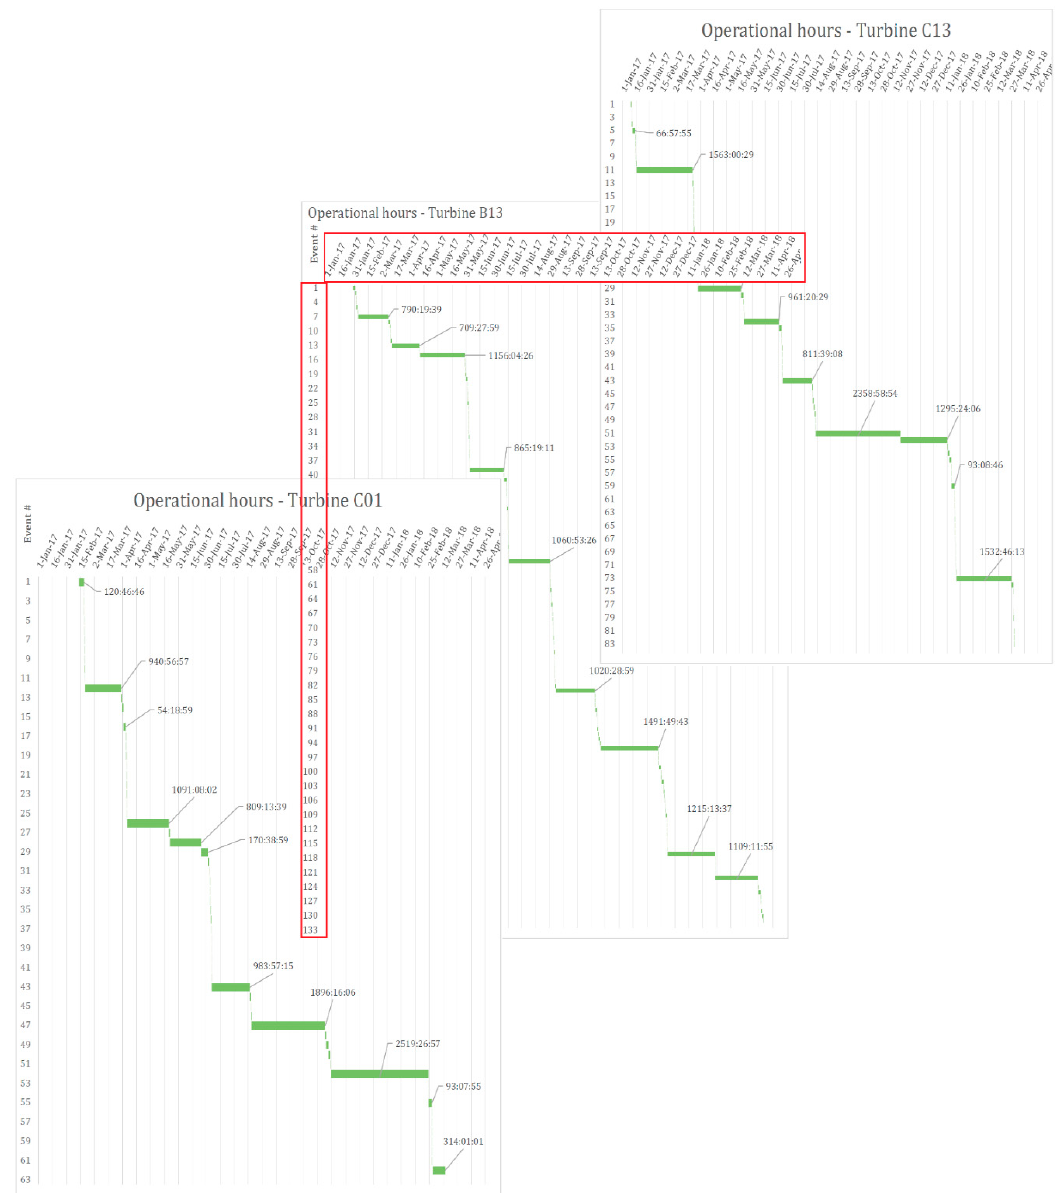
Figure 6. Operational Hours—Turbines (C13), (C01), and (C13).